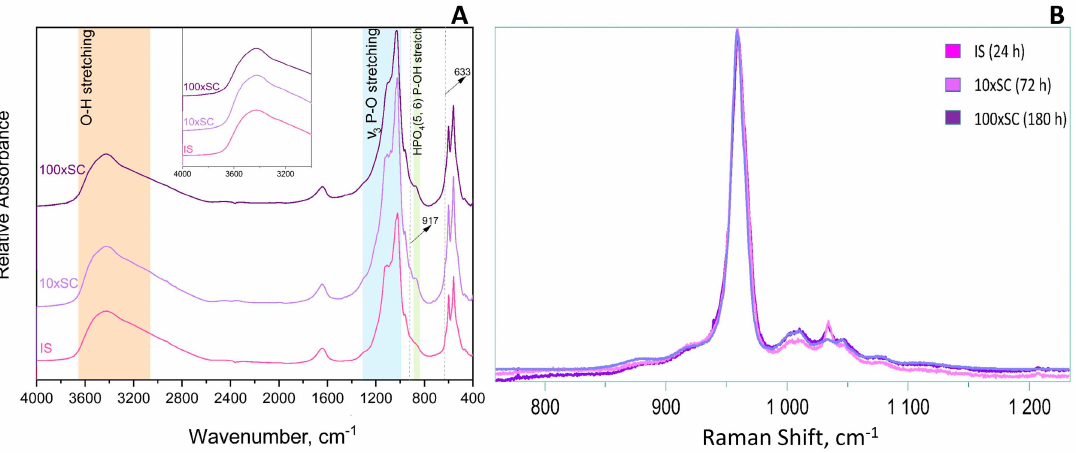
Figure 4. FTIR ( A ) and Raman ( B ) spectra of final OCP phases obtained in three levels of